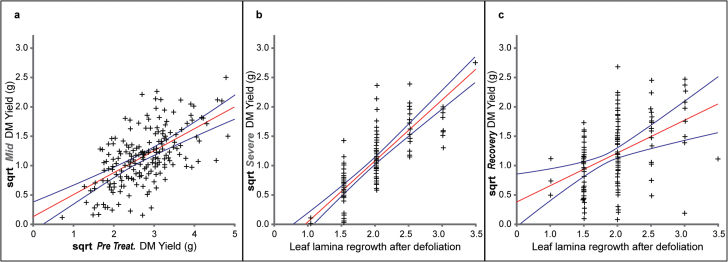
(a) Terms showing the strongest relationship with square root (sqrt) transformed DM production at (a) mid drought, (b) severe drought, and (c) after rehydration. The model explained 45% of the variation at mid drought (P < 0.001) with both DM-Pre and LR showing the strongest relationship, 65% at severe drought (P < 0.001), and 55% after recovery (P < 0.001) with leaf lamina regrowth after defoliation showing the strongest relationship for the two last time points. The two external curves in each graph represent the relationship with 95% confidence limits between fitted and observed data. This figure is available in colour at JXB online.